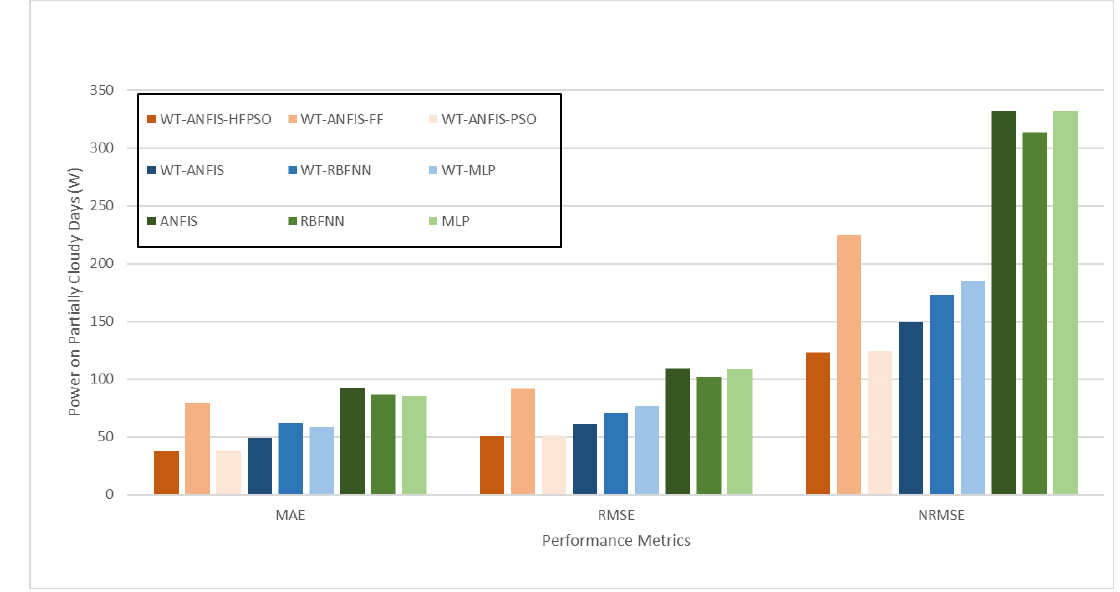
Figure 11. Comparison of forecasting models in terms of the MAE, RMSE and RMSE on partially cloudy days. Appl. Sci. 2019 , 9 , x